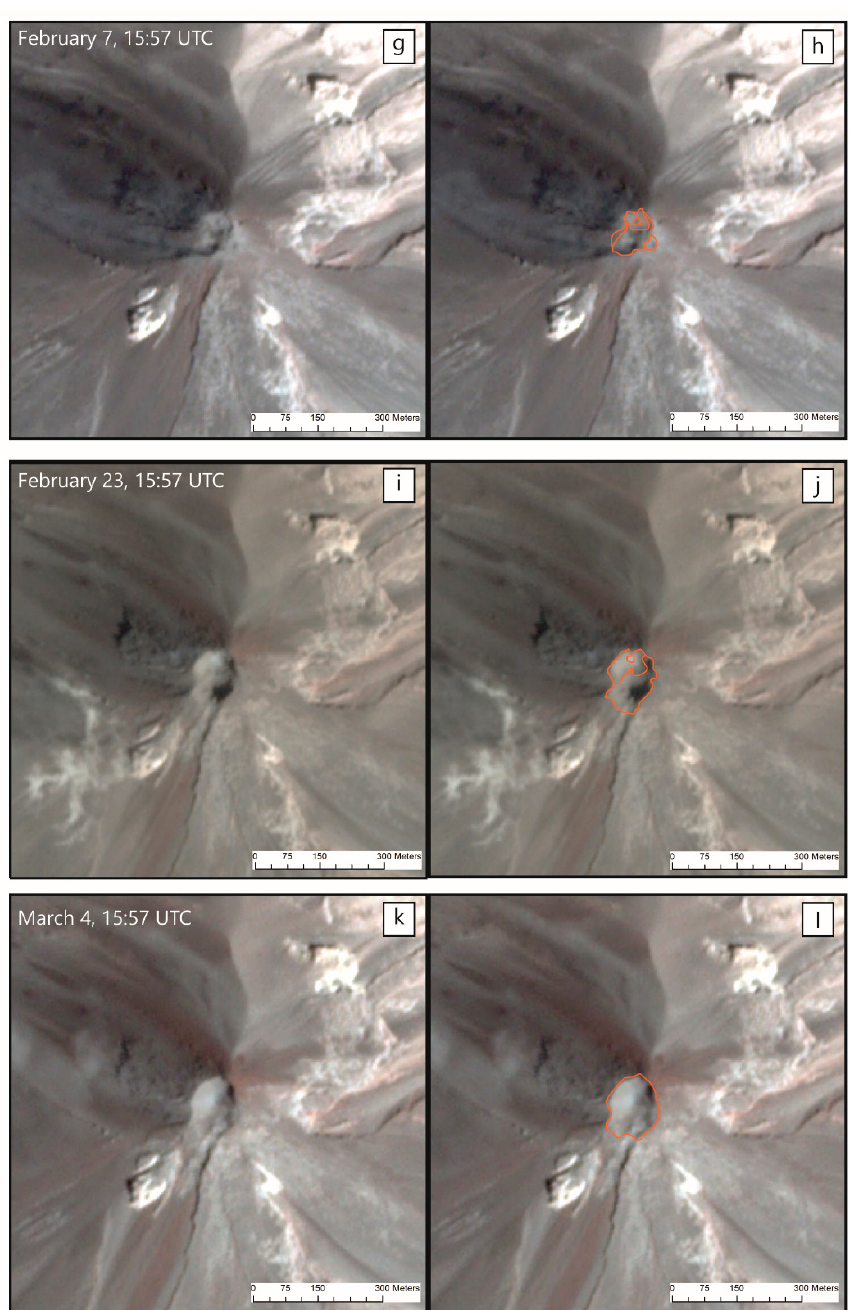
Figure 8. PlanetScope images of Fuego collected between December 2017 and March 2018, showing the evolution of the vent region of Fuego volcano. Left panels ( a , c , e , g , i , and k ) show the images without annotations; right panels ( b , d , f , h , j , and l ) show the mapped morphology and significant changes (orange lines). Figures a-d display the pre-eruption phase, whereas figures e–l represent the morphology right after the event to one month from it.